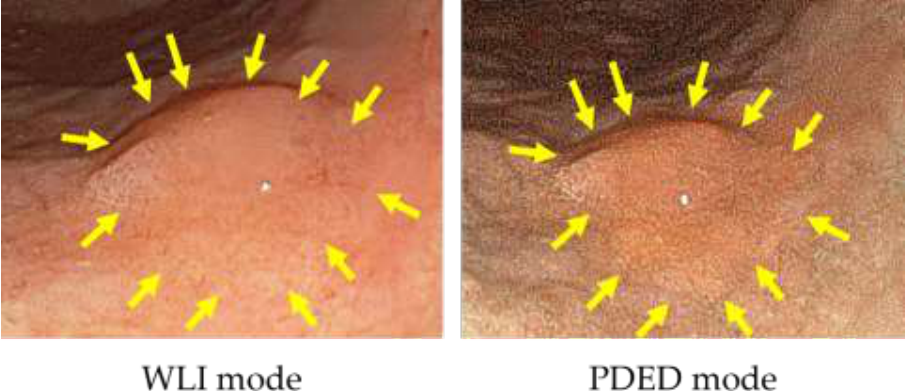
Figure 3. The 5-ALA mediated PDED with Sie-P2 for early gastric cancer. Analysis of all gastric tumors in which PDED was performed using Sie-P1 and Sie- P2 showed fluorescence in 42 of 49 lesions in 43 cases (85.7%). The examinations with Sie-P1 and Sie-P2 were associated with adverse events such as elevated white blood cell count (14.0% [6/43]), nausea (2.3% [1/43]), and aspartate aminotransferase elevation (2.3% [1/43]), but careful follow up revealed that these events resolved spontaneously.